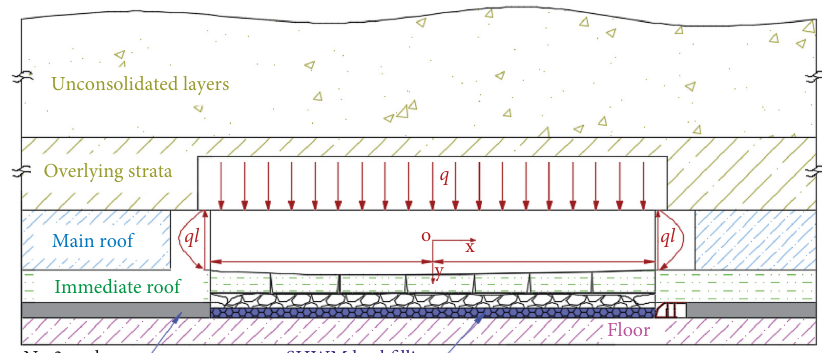
Figure 3: Overlying mechanical structure model.